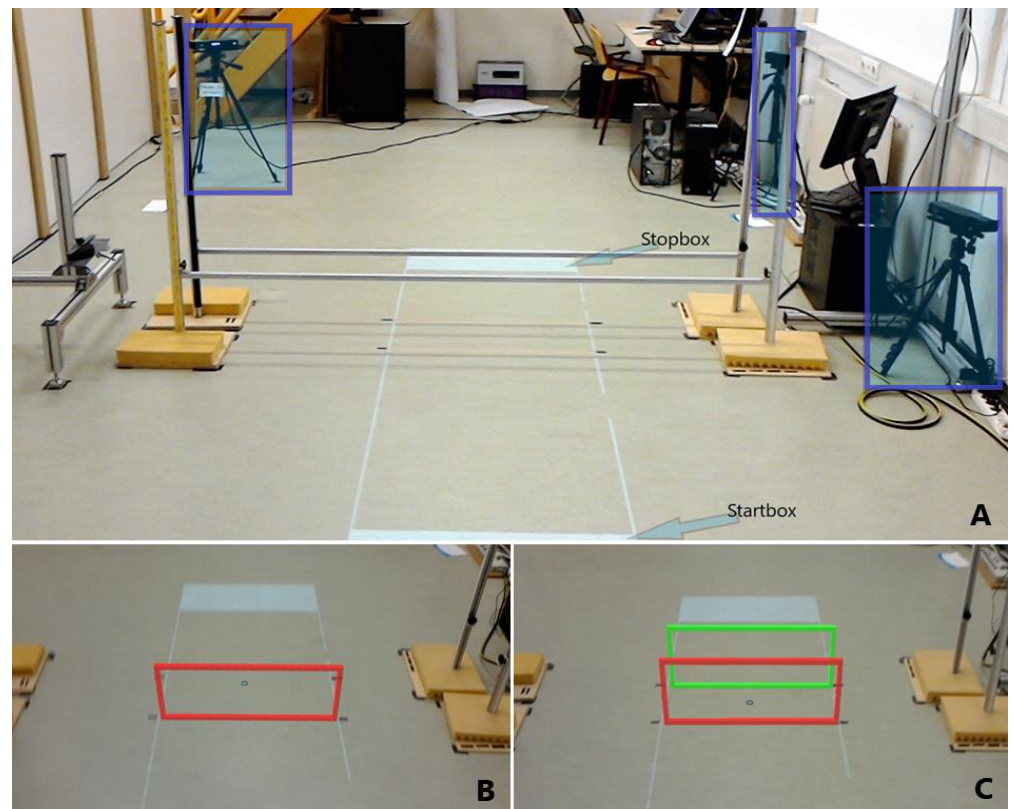
Figure 1. ( A ): Real obstacle with two hurdles (height 0.4 m, depth 0.3 m). White start and stop boxes projected onto the floor marked the beginning and end of the walking path. The three Kinect v2 sensors are highlighted with shaded boxes. ( B ): Holographic obstacle with one hurdle (height 0.4 m, depth 0.02 m). ( C ): Holographic obstacle with two hurdles (height 0.4 m, depth 0.3